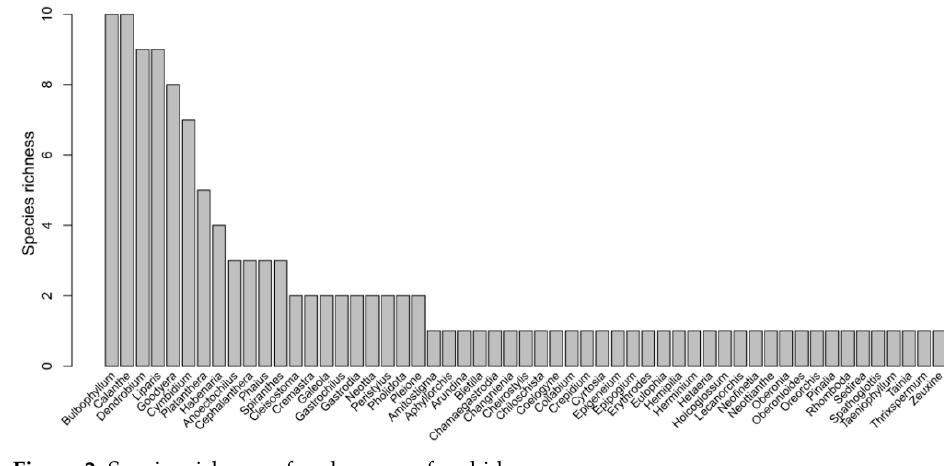
Figure 2. Species richness of each genus of orchids.